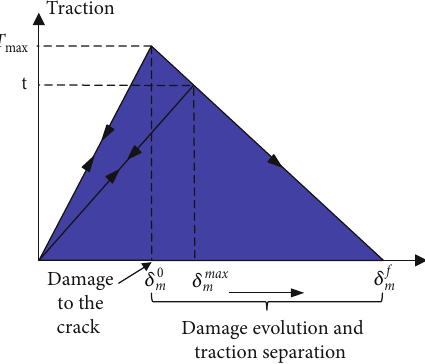
Figure 3: Bilinear traction separation